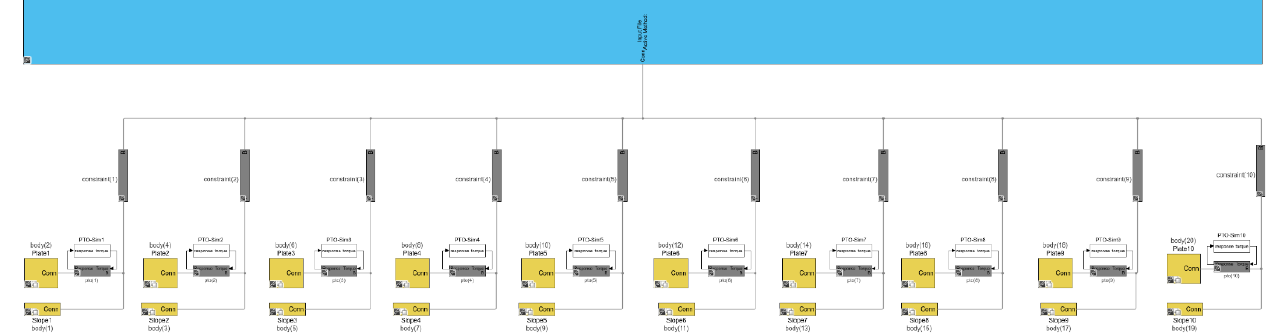
Figure 14. Array S-PWEC numerical model.